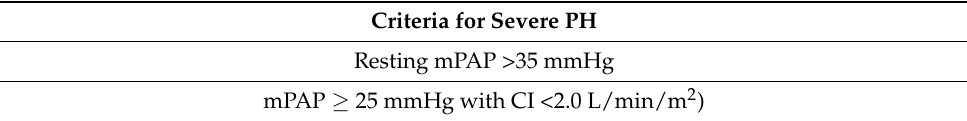
Table 2. Criteria for severe PH in patients with chronic lung disease. Criteria for Severe